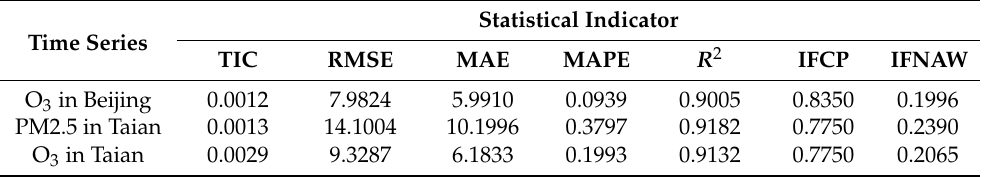
Table 6. Statistical indices of prediction of O 3 in Beijing, and PM2.5 and O 3 in Taian.